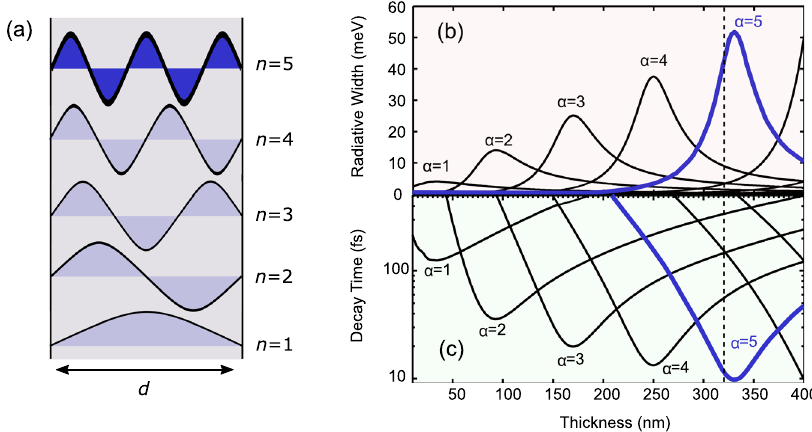
Figure 1. ( a ) Schematic illustration of excitonic wavefunctions confined in a thin film. ( b ) Calculated radiative widths and ( c ) decay time as a function of film thickness in a CuCl thin